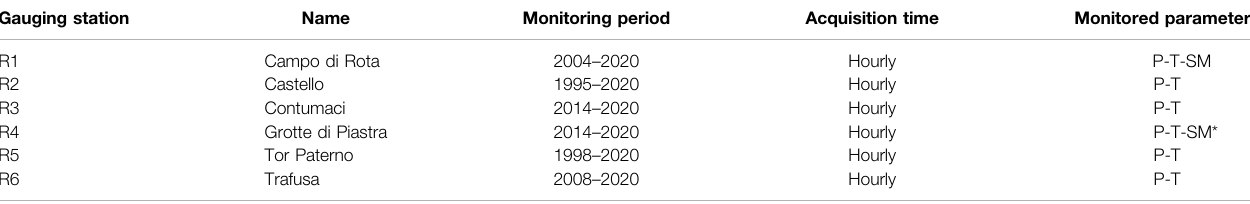
TABLE 1 | Name, monitoring period, acquisition time, and monitored parameters of the Estate gauging stations from R1 to R6 (see Figure 1 for their location). Gauging